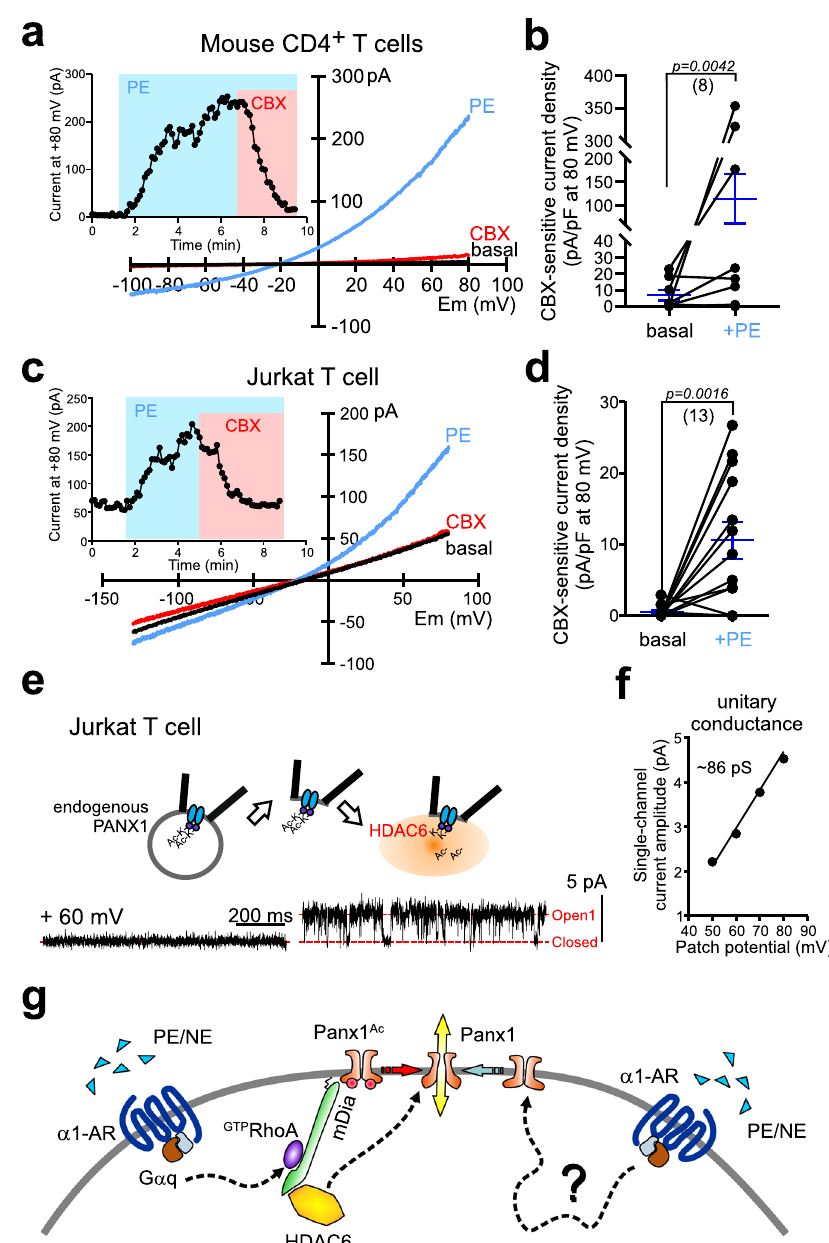
Fig. 8 HDAC6 activates native Panx1 channels in T lymphocytes. a Exemplar recording from a freshly isolated mouse CD4 + T cell that responded to PE (20 μ M) with an increase in whole-cell CBX-sensitive current and I – V characteristics of Panx1. b Summary data (mean ± s.e.m, blue lines) showing CBX- sensitive whole-cell current density in mouse CD4 + naïve T cells, before and after bath application of 20 μ M PE ( n = 8; 5 T reg and 3 T eff cells examined over 3 independent experiments); one-tailed paired t -test (t = 2.014, df = 7). c Representative whole-cell recording from Jurkat T cell that showed increased CBX-sensitive PANX1-like current in response to PE (20 μ M). d Summary data (mean ± s.e.m, blue lines) showing CBX-sensitive currents before and after PE stimulation on individual Jurkat T cells; one-tailed paired t -test ( n = 13 cells examined over 3 independent experiments; t = 3.682, df = 12). e,